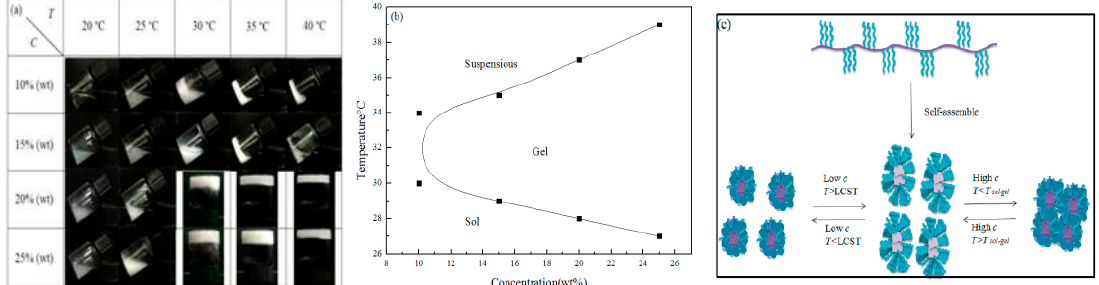
Figure 7. Photographs of the different concentrations tBG4 copolymer aqueous solution at different temperature ( a ), the sol–gel transition phase diagram of tBG4 ( b ), and schematic representation of the self-assembled thermo-sensitive core–shell micelles ( c ).